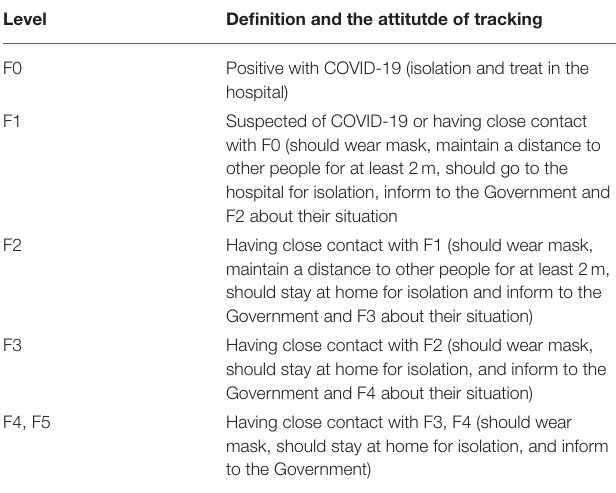
TABLE 1 | F0–F5 evaluation system for epidemiological tracing contacting people who are related to a confirmed case of COVID-19 in Vietnam.